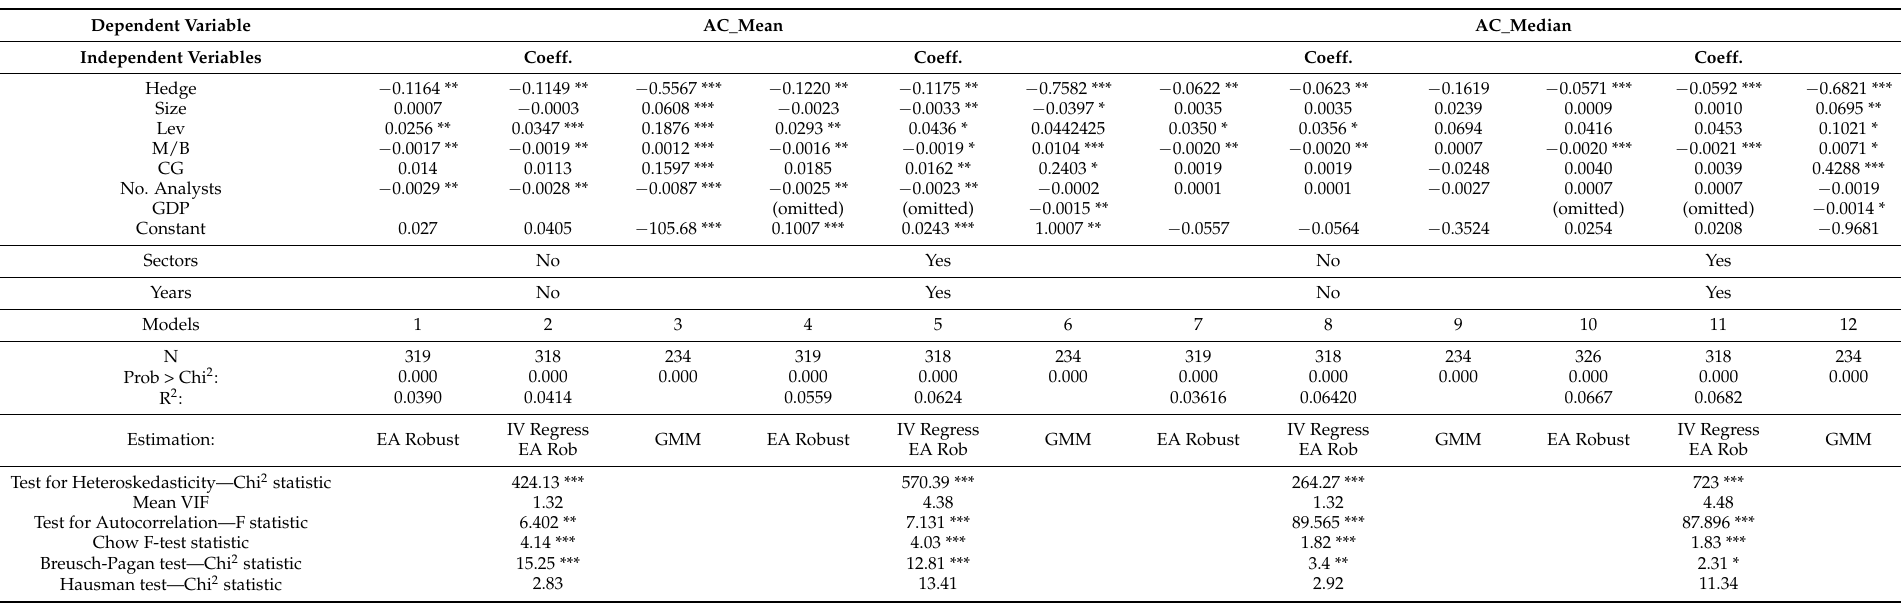
Table 3. Estimated models: Effects of the use of hedging on agency